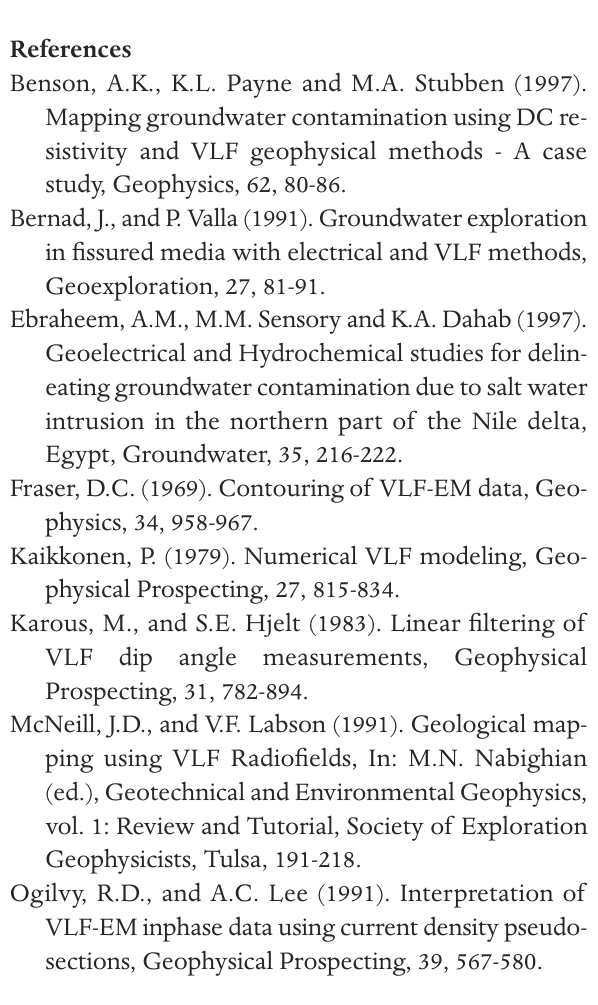
Figure 6. Geophysical data acquisition map showing fracture points.